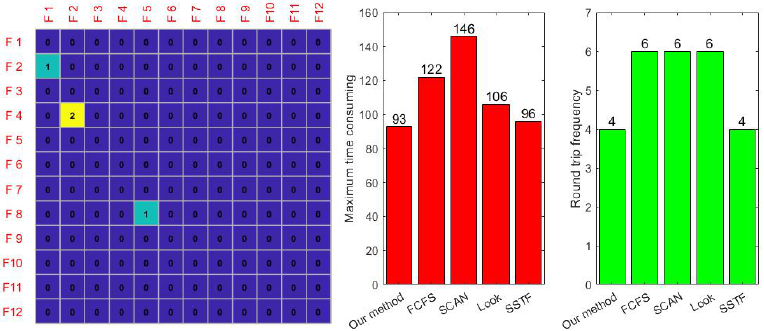
Figure 7. Visualization results of double control reservation elevator in Example 2.